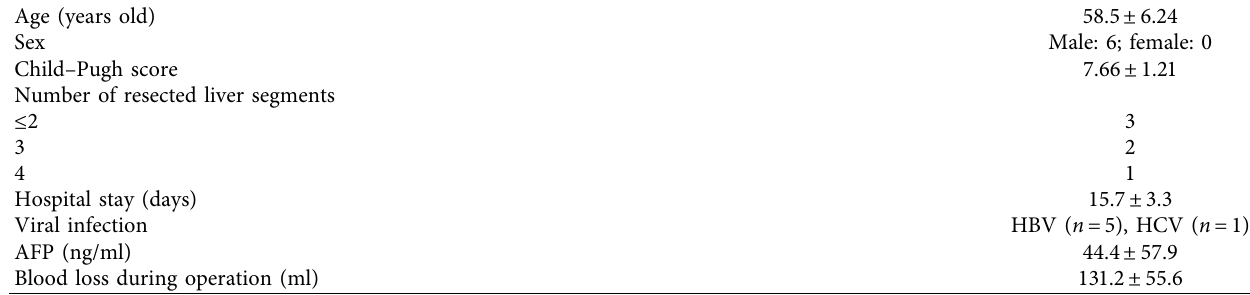
Table 1: Patient characteristics of 6 patients.